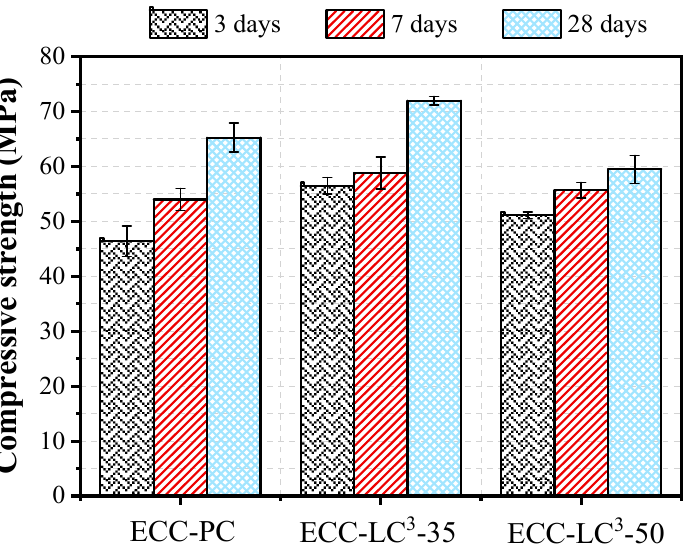
Figure 9. Compressive strength.